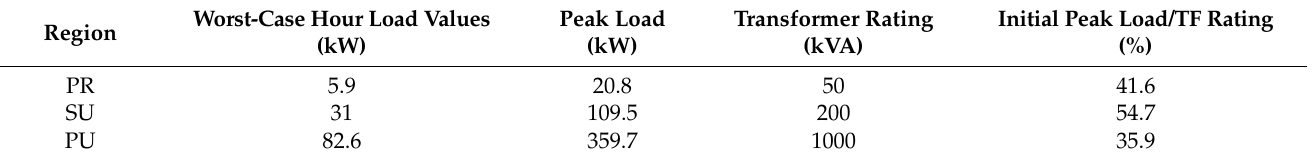
Table 4. Average load values of the networks under balanced PVs in three regions for worst-case hours (minimum load values) and peak load calculated among all the 8760 h.